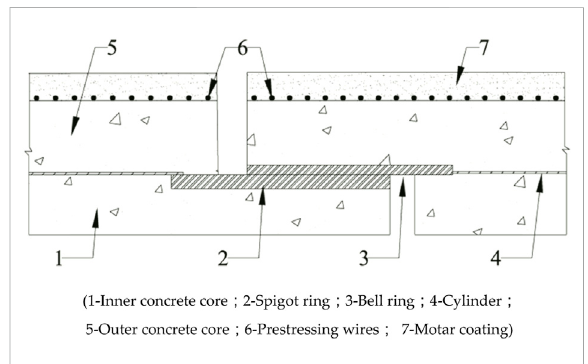
FIGURE 2 Schematic diagram of the simpli fi ed socket and spigot.